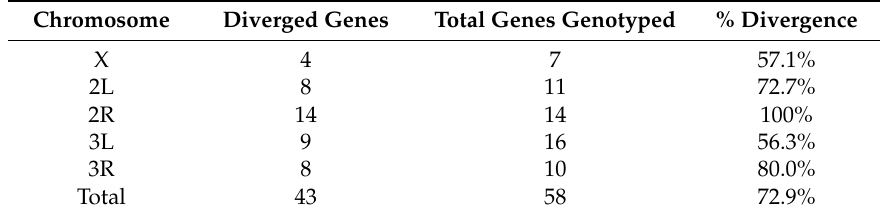
Table 1. The number of immune genes containing a SNP that di ff er between at least one pair of taxa. Chromosome Diverged Genes Total Genes Genotyped